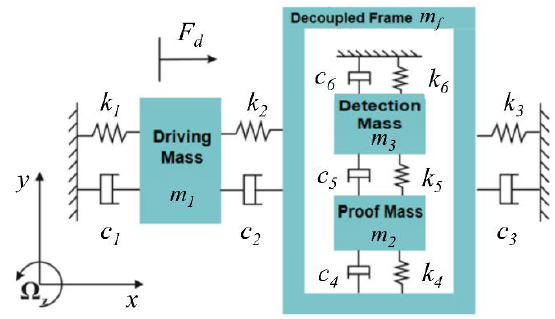
Figure 1. Structural schematic diagram of the micro gyroscope with two-degree-of-freedom (2-DOF) drive-mode and sense-mode.